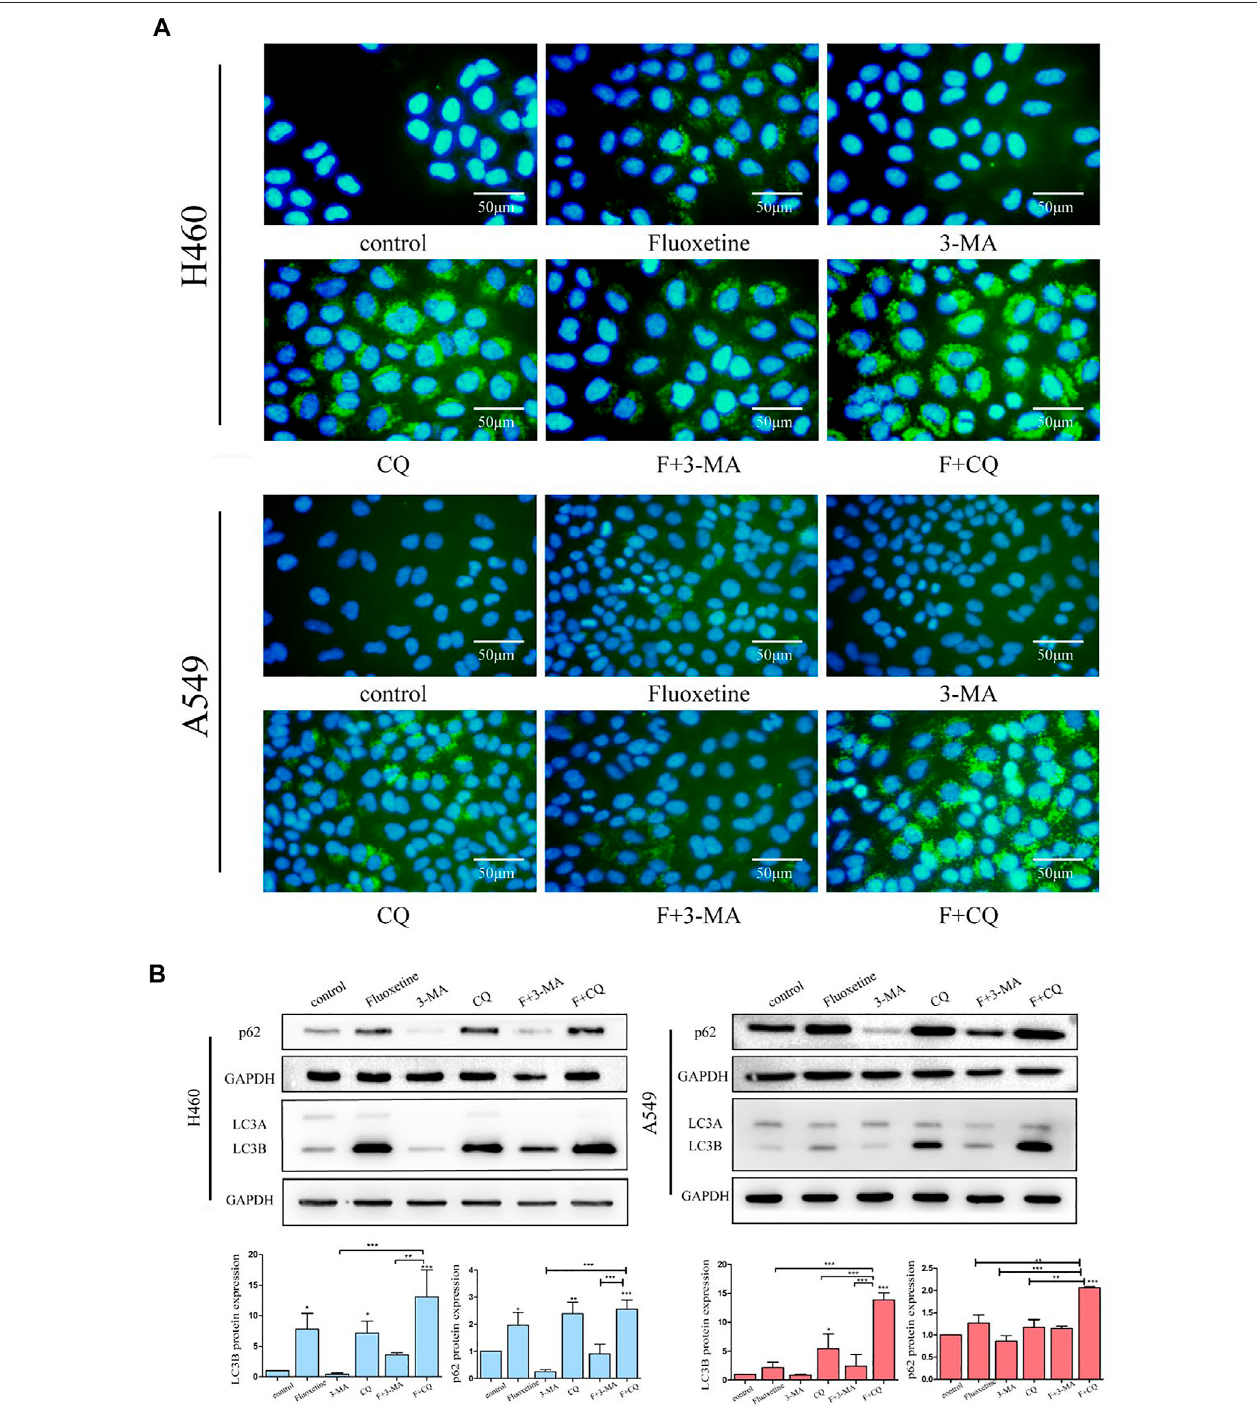
FIGURE 4 | Fluoxetine induced autophagy in a dose and time-dependent way (A) immuno fl uorescence of LC3 (green) and DAPI (blue) was used to observe the autophagy. Cells were treated with 20 μ M fl uoxetine(F), 1 mM 3-MA, 40 μ M CQ, the combinationof fl uoxetine plus rapamycin, and fl uoxetine plus chloroquinefor 24 h. Scale bars 50 μ m. (B) Result of the Western blot of LC3 and p62. The treatment of drugs was used as described previously. Quantitative analysis of optical band densitometry was conducted. Data are presented as mean ± SD; * p < 0.05, ** p < 0.01, *** p < 0.001.